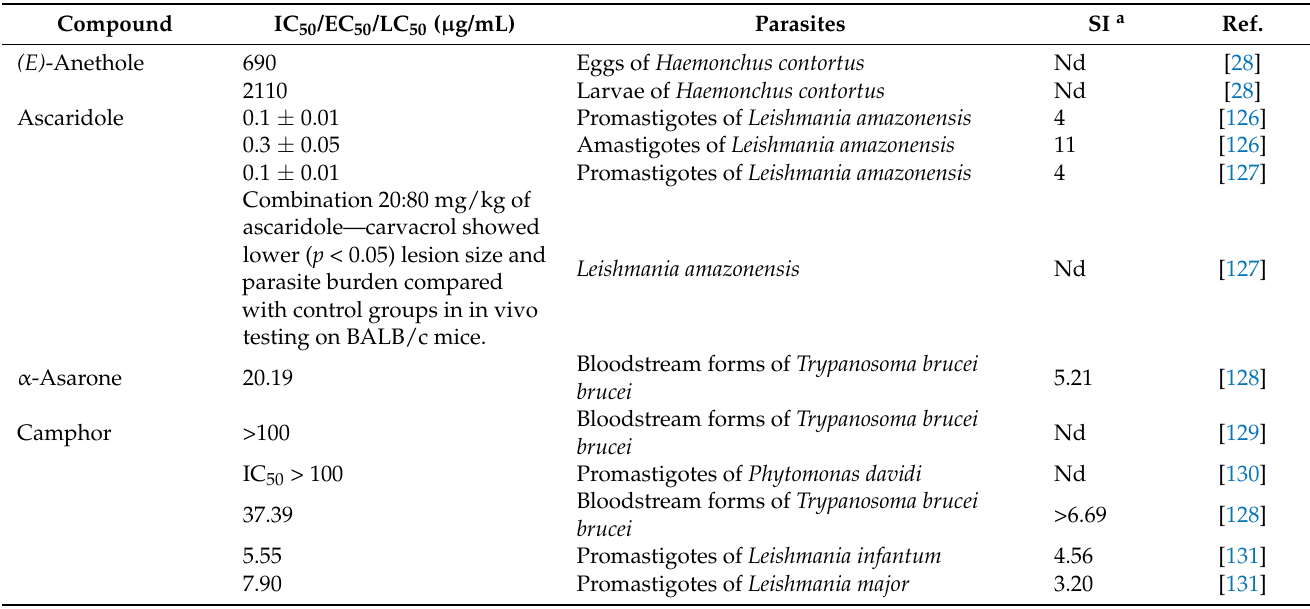
Table 8. Summary of antiparasitic activities of essential oil